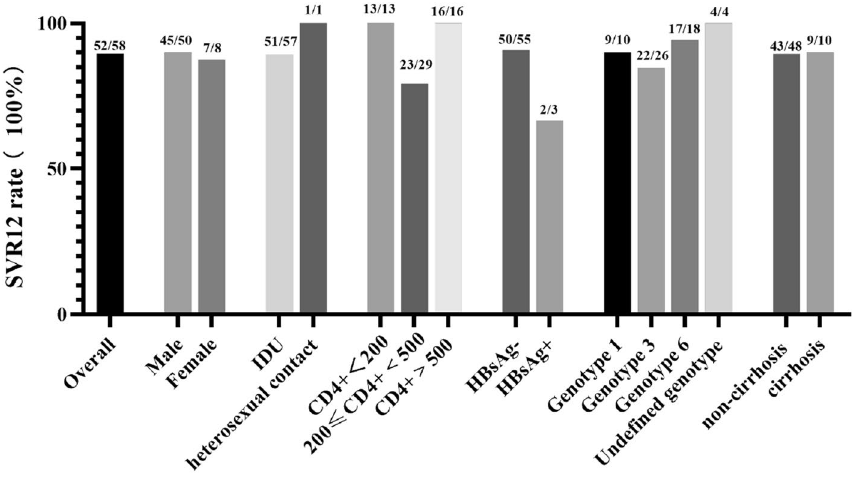
Figure 1. SVR12 rate in HIV–HCV coinfected patients of different subgroups.